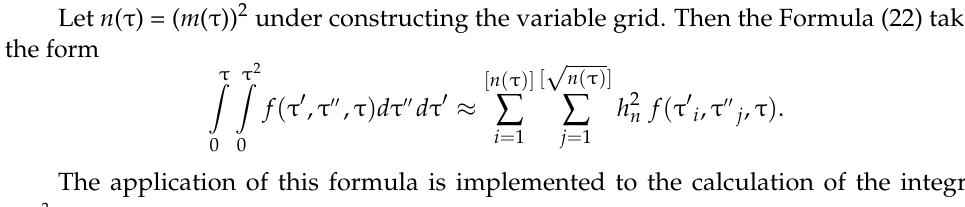
Table 16. Calculation of integral  